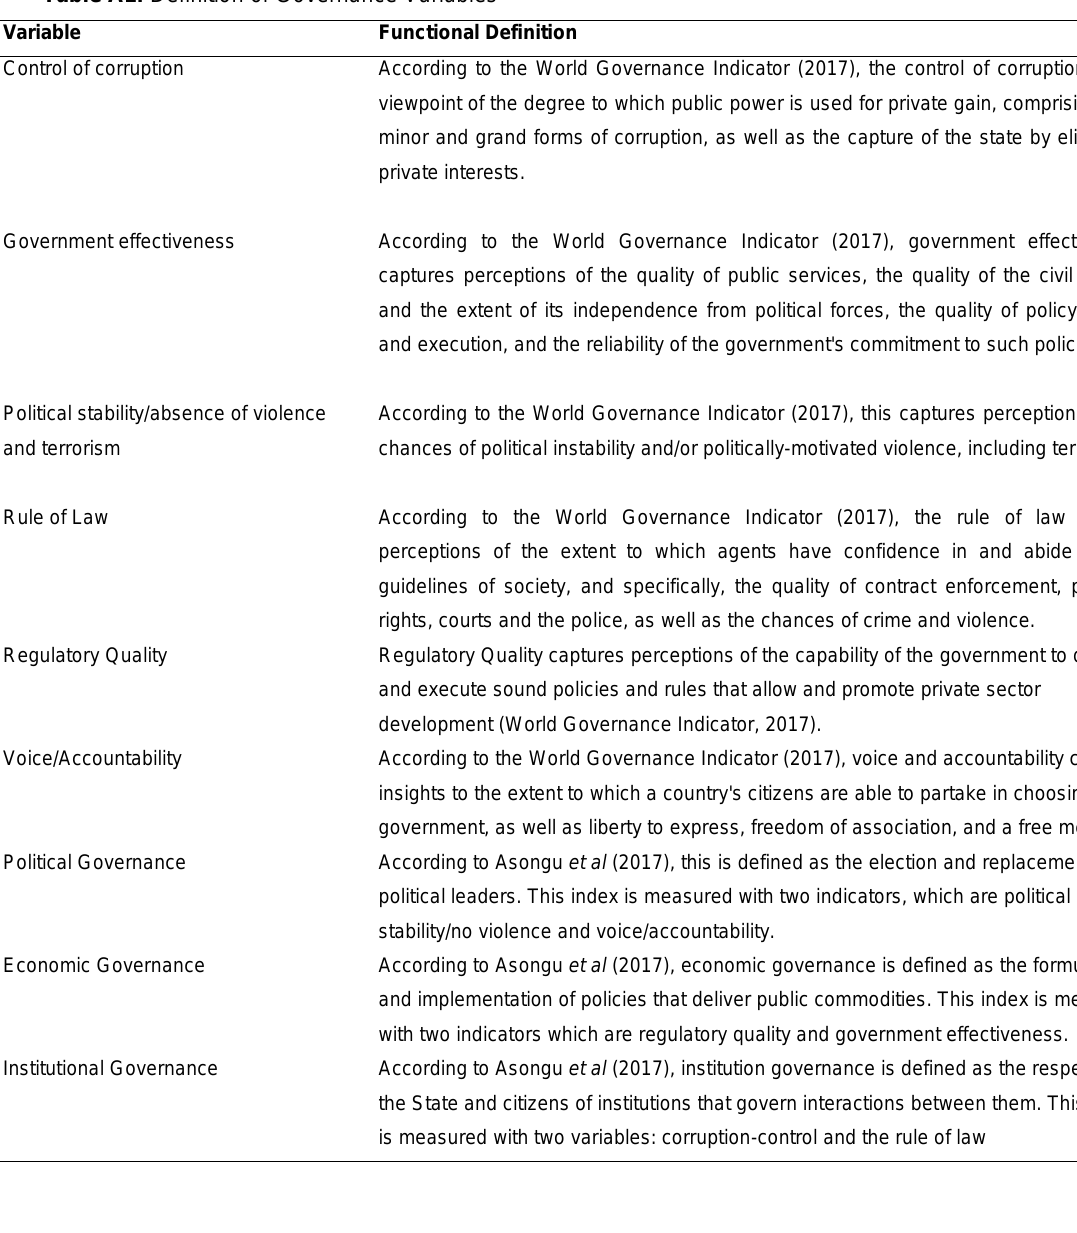
Table A1: Definition of Governance